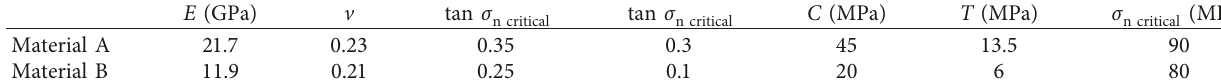
Table 4: Calibration results of